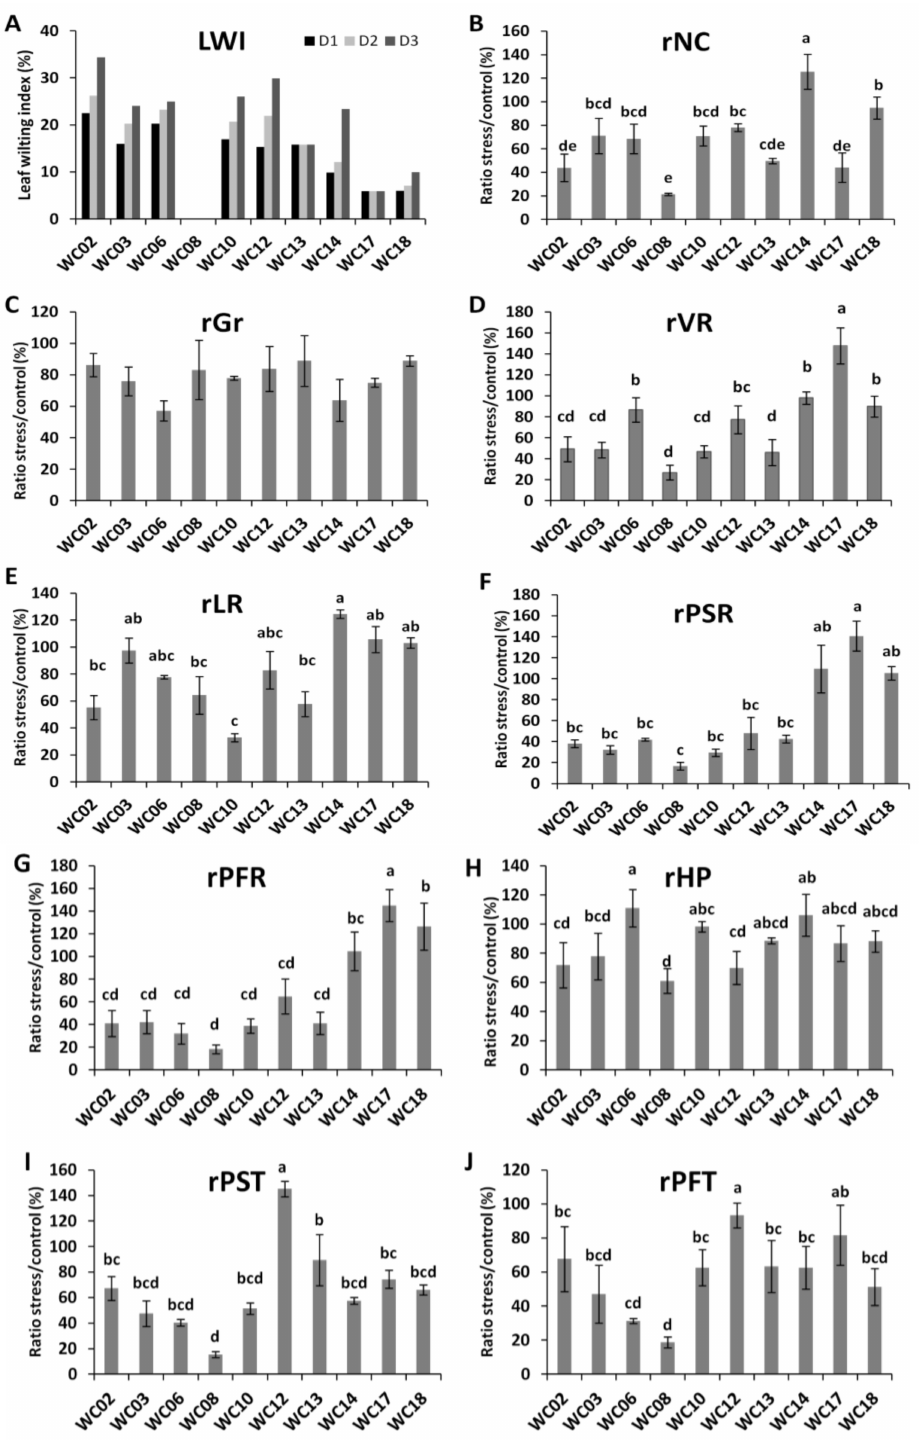
Figure 1. Effects of water deficit on sesame plant growth and yield relative indexes. ( A ) leaf wilting index (LWI); ( B ) relative number of capsules (rCN); ( C ) relative number of seeds per capsule (rGr); ( D ) relative root volume (rVR); ( E ) relative primary root length (rLR); ( F ) relative root dry weight (rPSR); ( G ) relative root fresh weight (rPFR); ( H ) plant height (rHP); ( I ) relative stem dry weight (rPST); ( J ) relative fresh weight (rPFT). Different letters above bars represent significant difference ( p < 0.05) between genotypes. D1, D2, D3 represent the three consecutive days of LWI